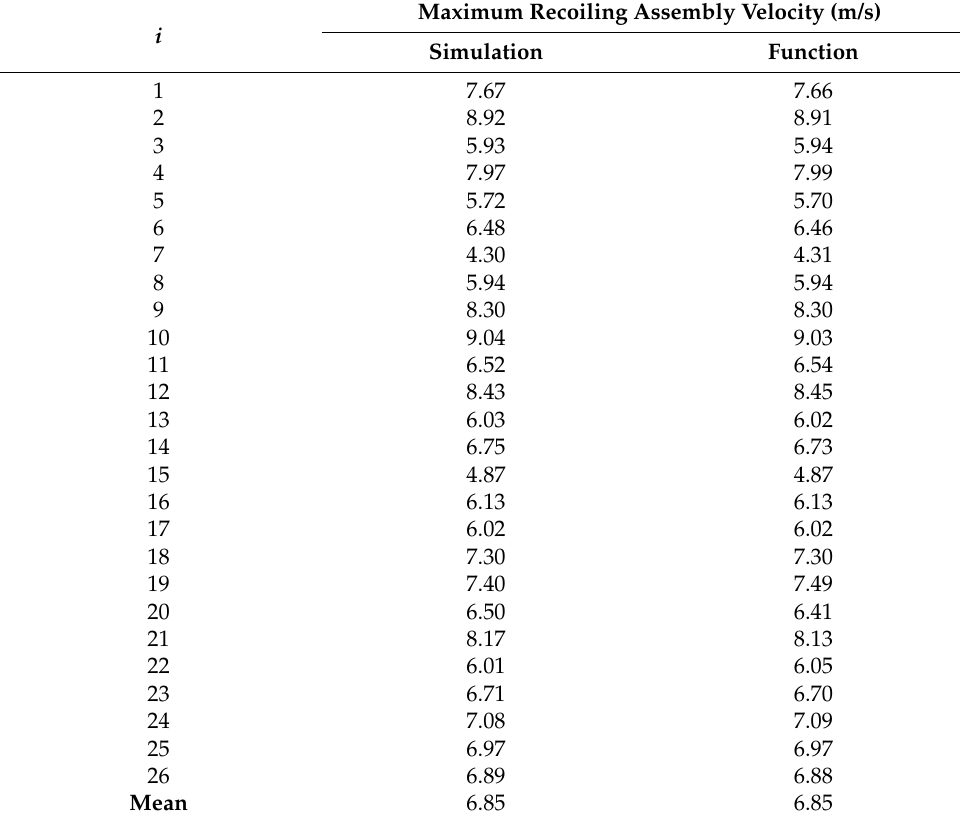
Table 10. The results of simulation compared to the results approximated by the obtained function for the Bi